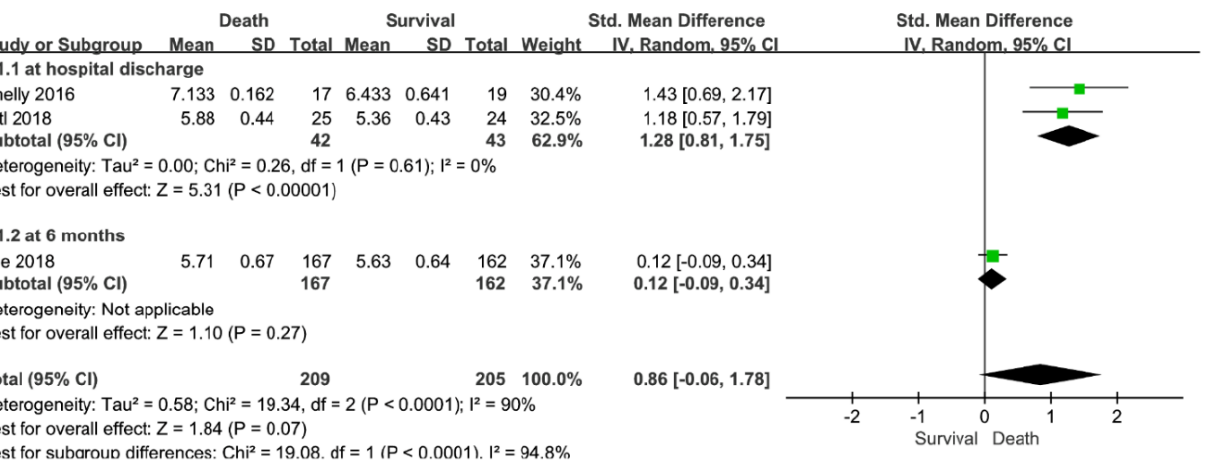
Figure 2. Forest plot for the association of ONSD with a poor neurological outcome. Abbreviations: CI = confidence interval; ONSD = optic nerve sheath diameter; SD = standard deviation.